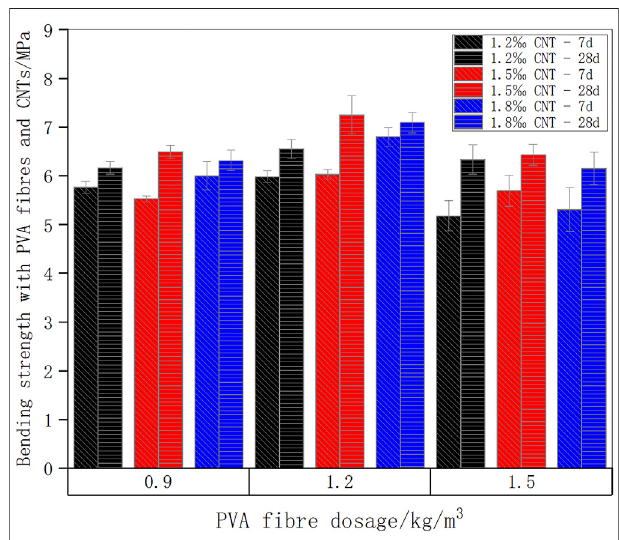
FIGURE 4 | Compressive strength test results of geopolymer strengthened using PVA fi bres and CNTs.